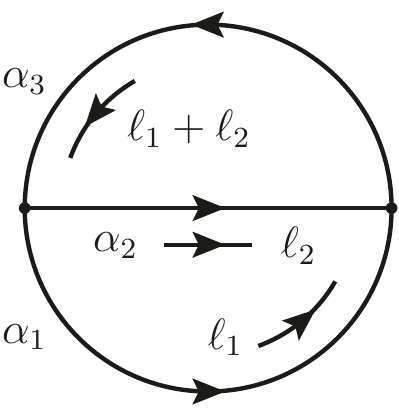
Figure 1 . Momentum (cid:13)ow of a two-loop Feynman